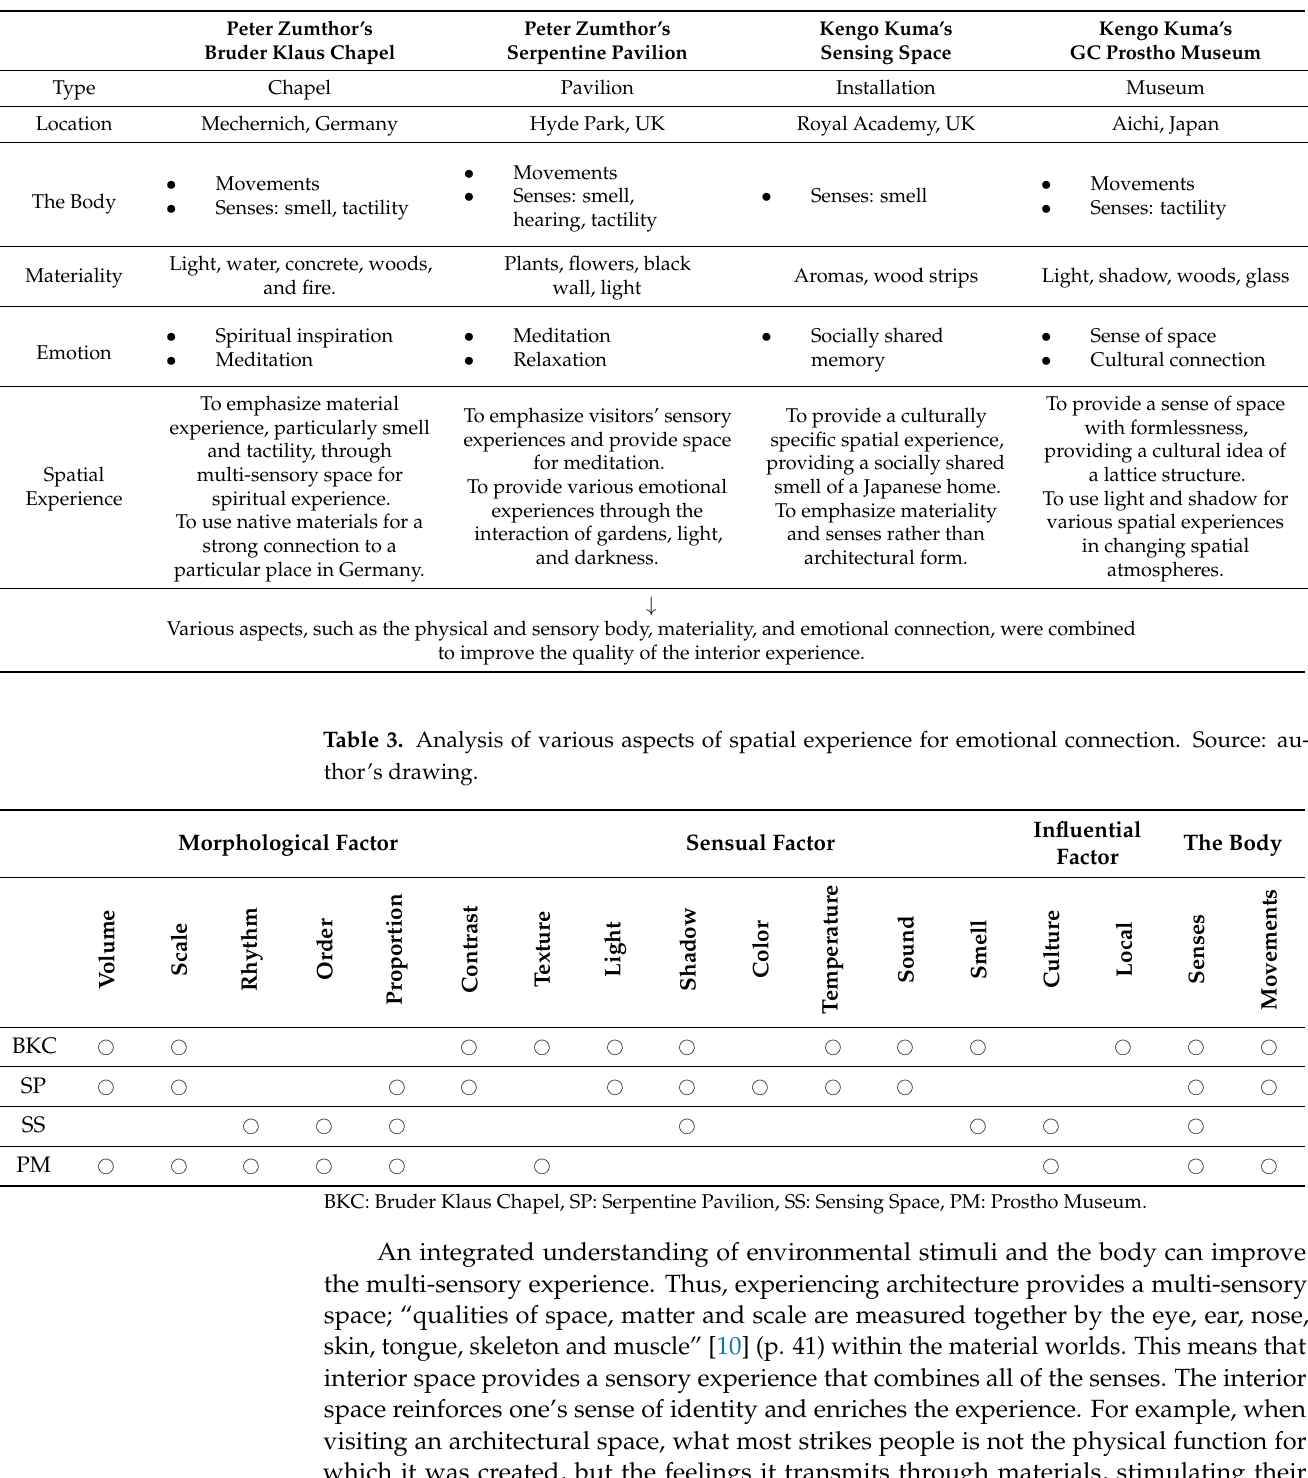
Table 2. Characteristics of architectural projects. Source: author’s drawing.